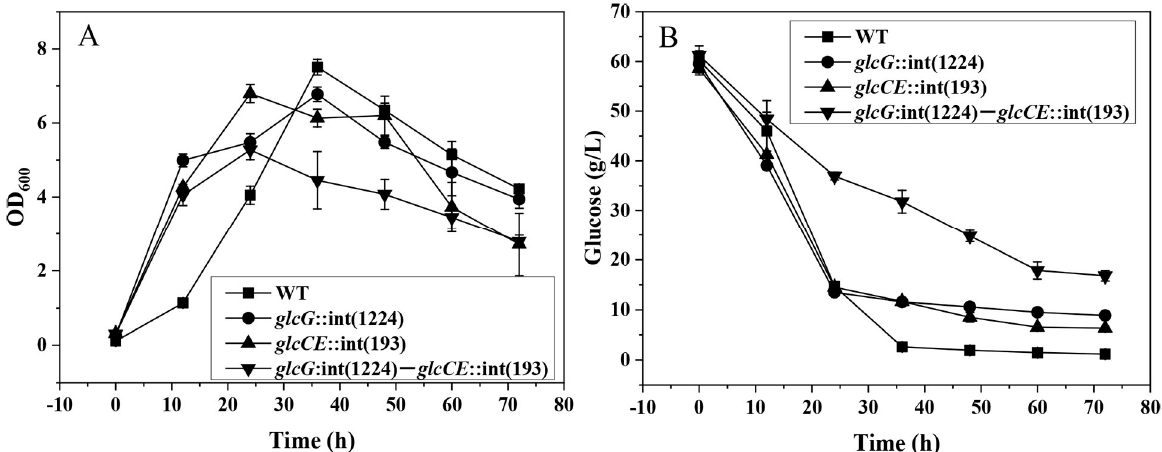
Figure 1. Growth curves ( A ) and residual glucose concentrations ( B ) of C. acetobutylicum wild type,